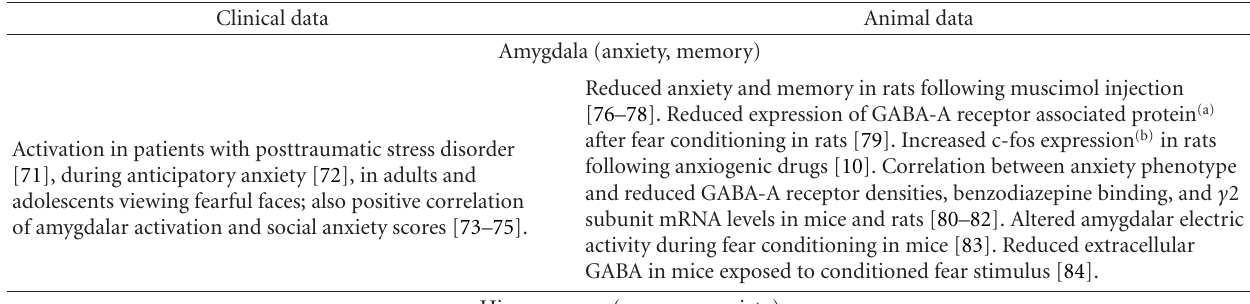
Table 2: Clinical and preclinical data linking common GABAergic brain areas to pathogenesis of anxiety and depression. Clinical